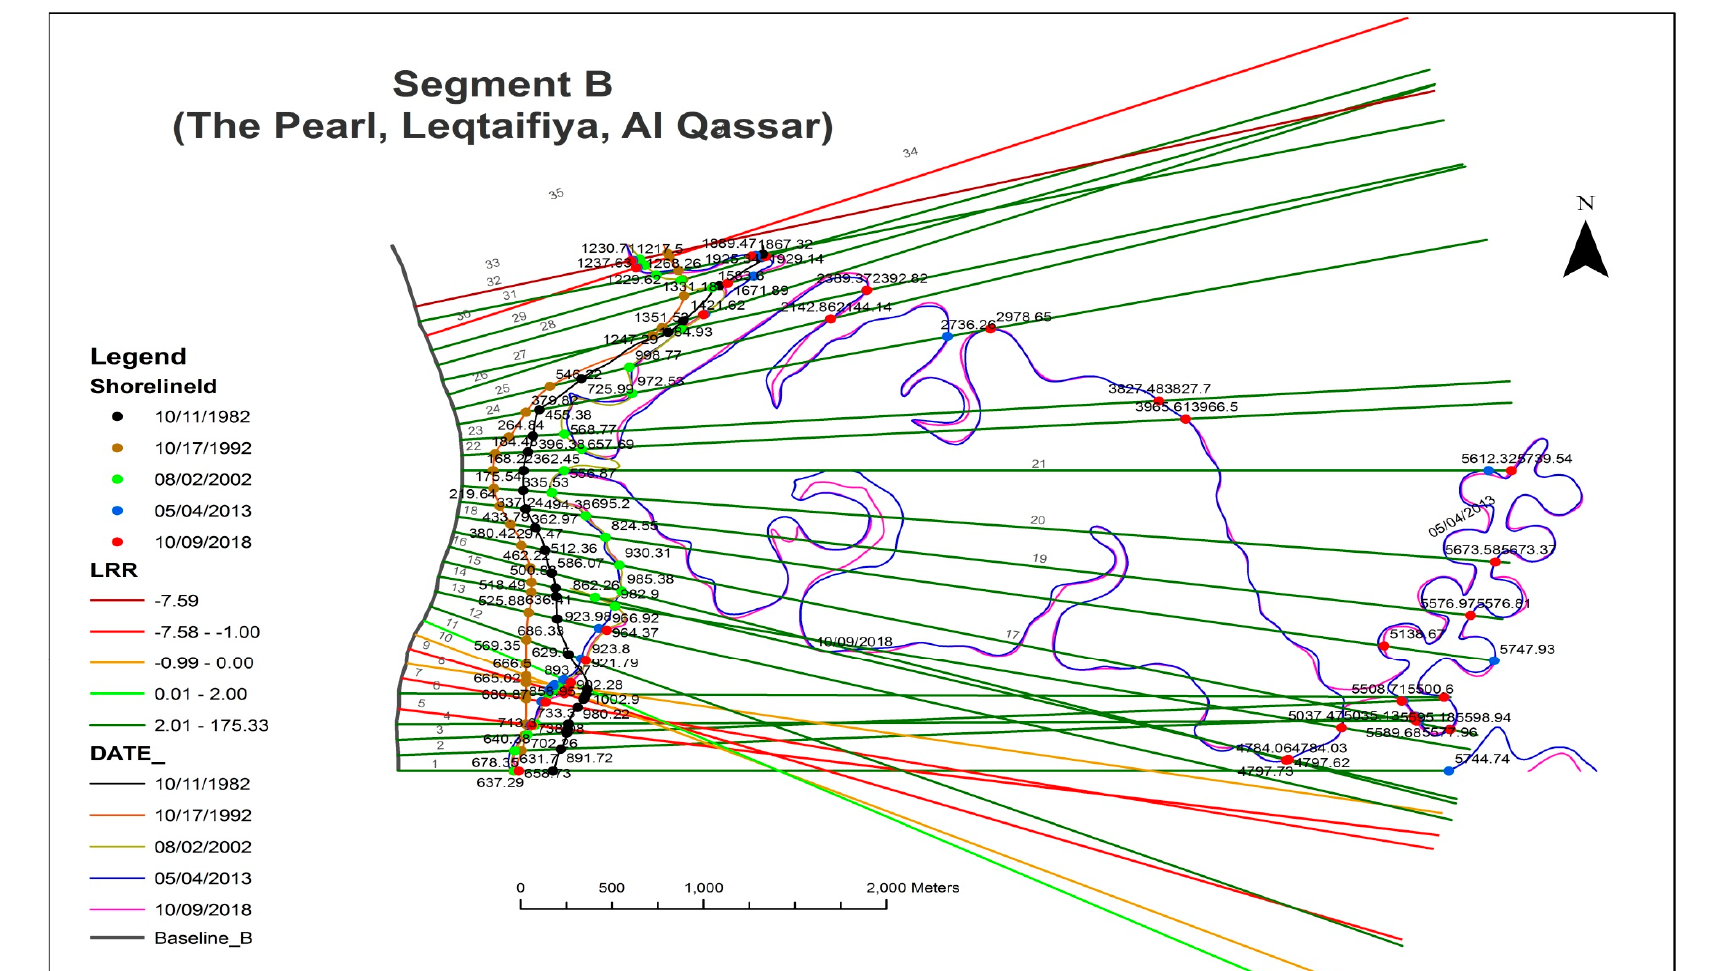
Figure 11. Shoreline map of The Pearl, Leqtaifiya, and Al Qassar area.